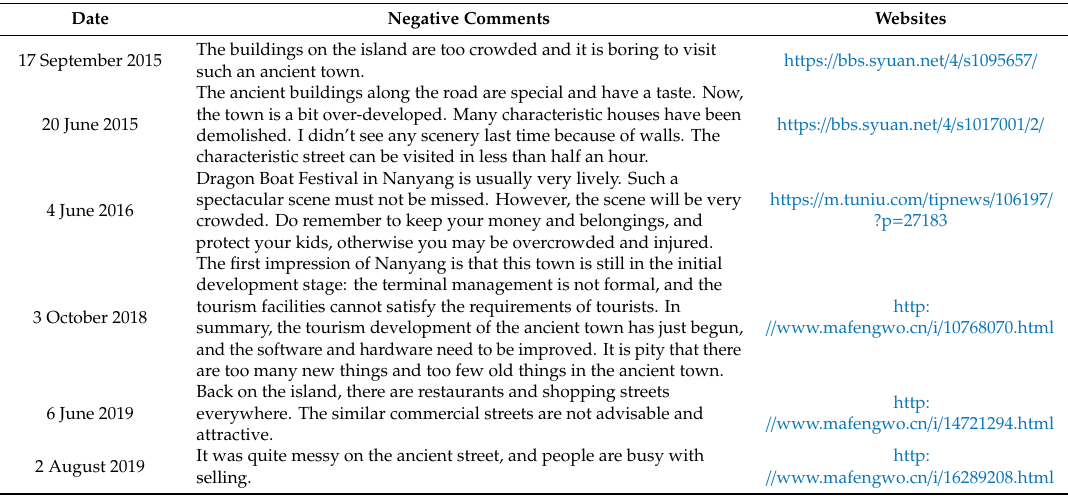
Table 2. Negative comments and source websites (the initial comments were written in Chinese and the authors translated them into English).